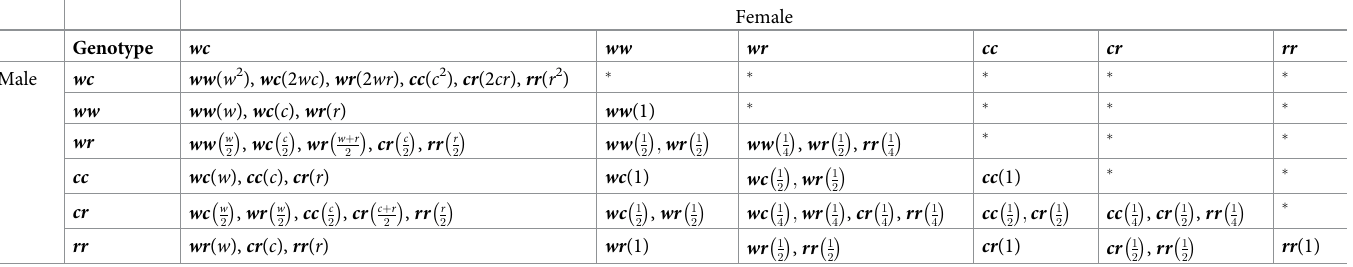
Table 2. Possible values for each offspring g 0 in inheritance table i ( g bilities w = 1/2 −